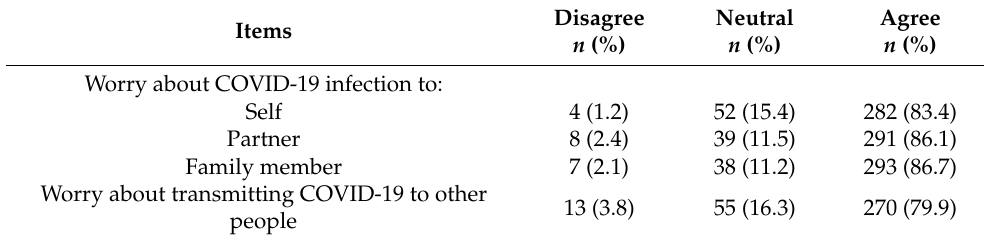
Table 4. COVID-19-related anxiety.